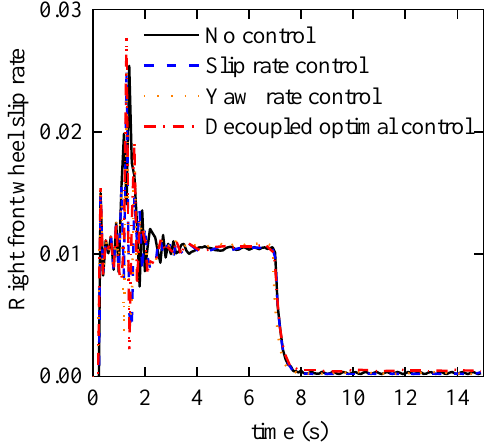
Figure 13. Right front wheel slip rate.